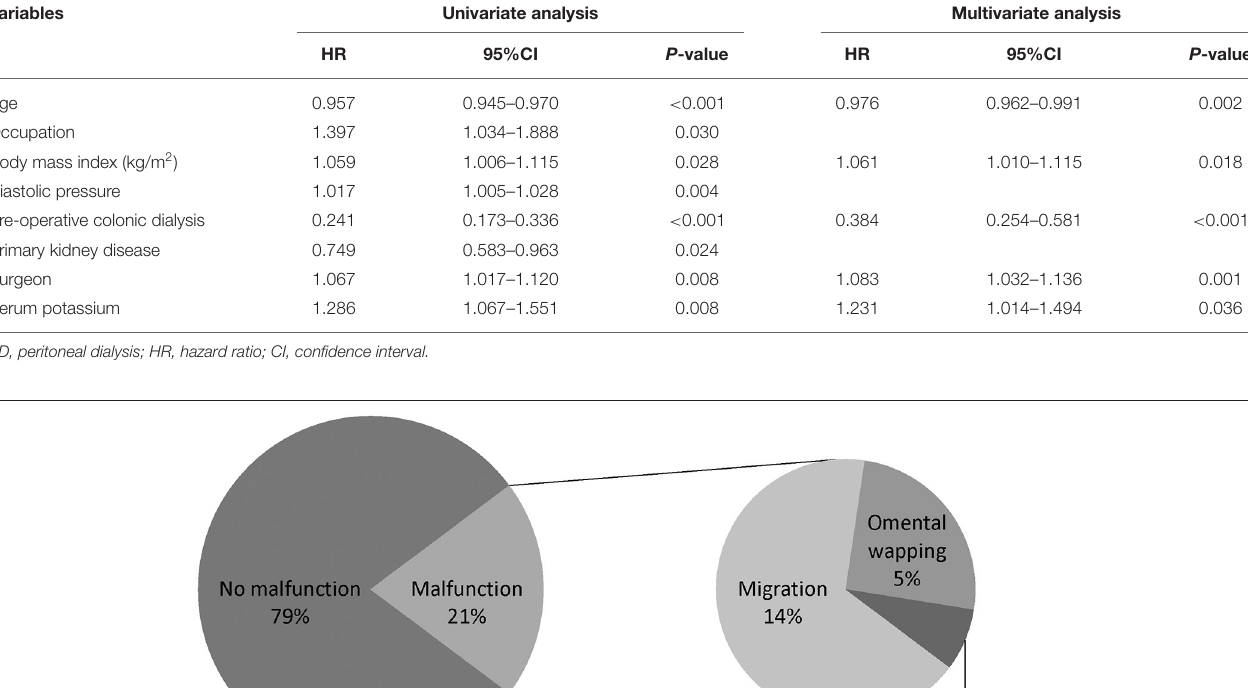
TABLE 3 | Univariate and multivariable Cox regression analyses of the risk factors of PD catheter malfunction. Variables